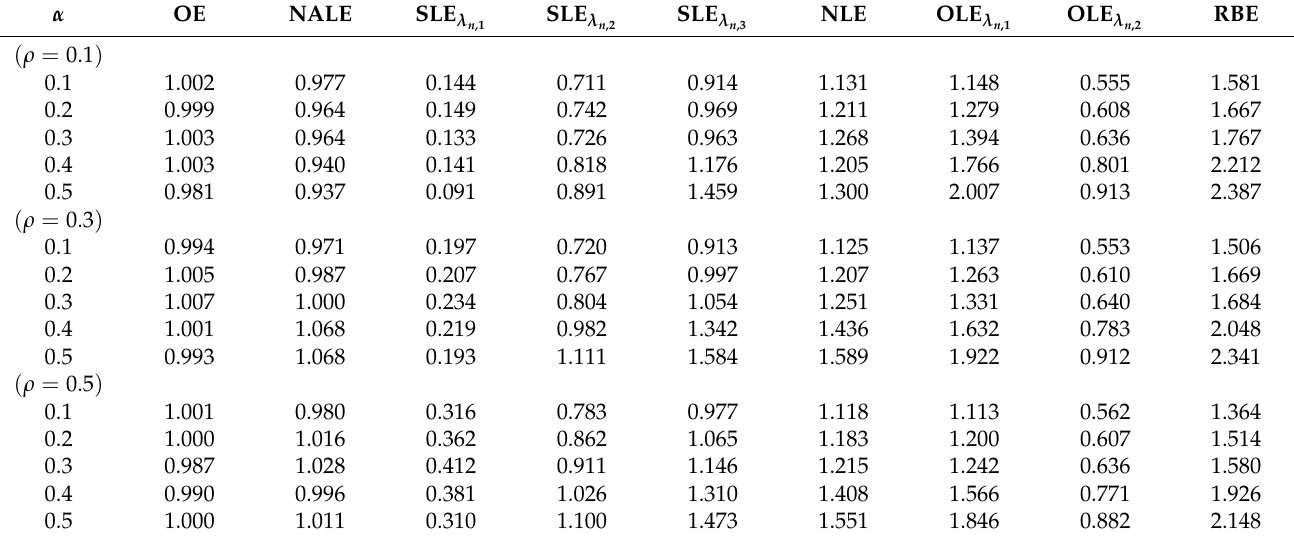
Table 4. Average RE of various estimators, true σ 2 =